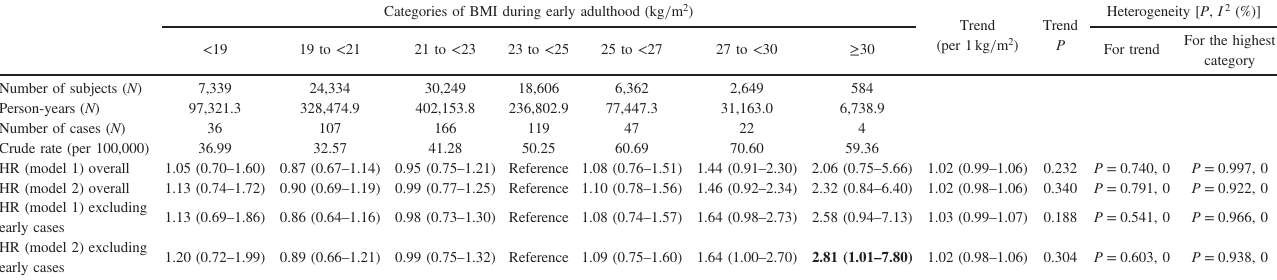
BMI, body mass index. Model 1 adjusted for age and area (within each study for JPHC and JACC). Model 2 adjusted for age, area, smoking (pack-years [PY] = 0, 0 < PY ≤ 20, >20, or unknown), drinking (never, <1 week = day, current <23g = day, 23 to <46g = day, 46 to <69g = day, ≥ 69g = day, or unknown), and history of diabetes (yes, no, or unknown). HRs values in bold show statistical signi fi cance. Table 3. Hazard ratios (HR) and 95% con fi dence intervals (CI) for pancreatic cancer risk according to category of BMI during early adulthood among males Categories of BMI during early adulthood (kg = m 2 )